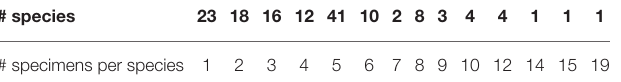
TABLE 1 | Number of species and specimens in dataset. #